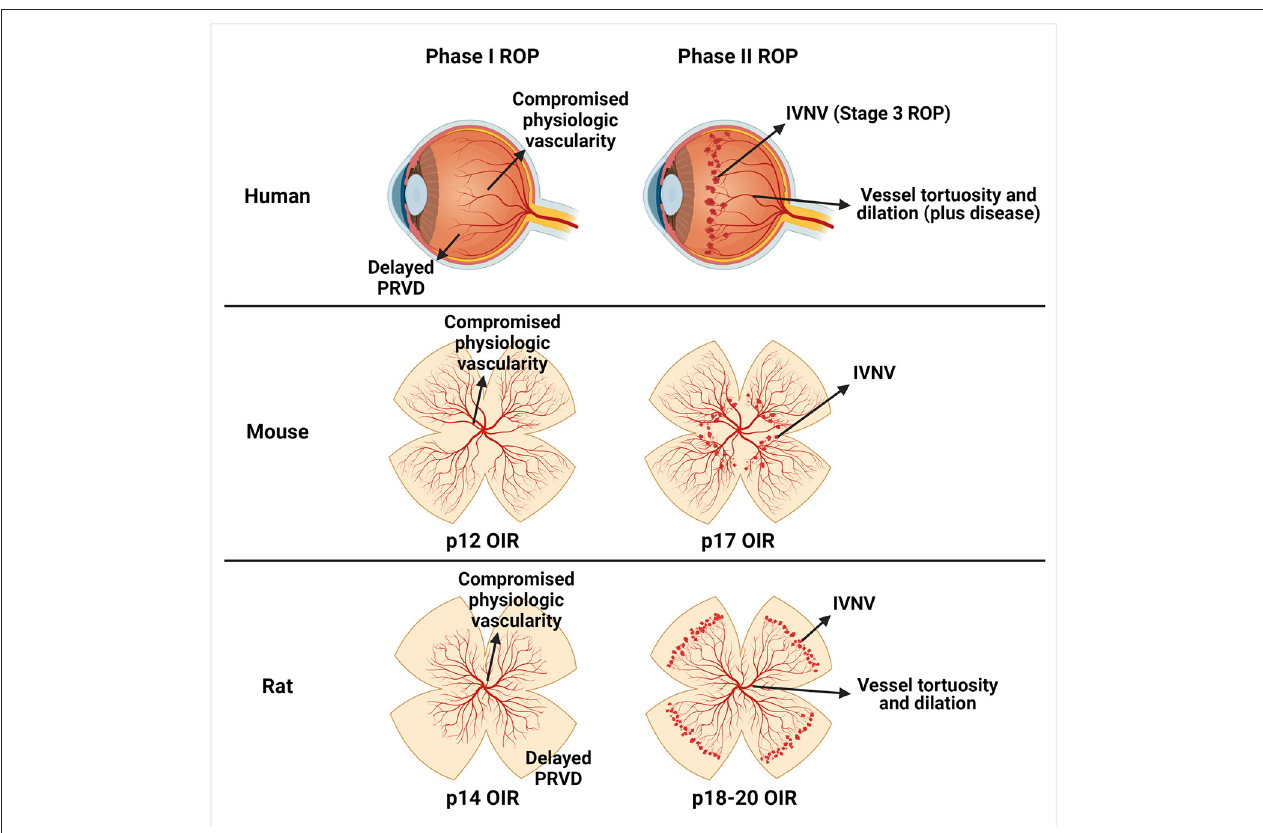
FIGURE 1 | Schematic representation of similarities between human retinopathy of prematurity (ROP) and oxygen-induced retinopathy (OIR) models. Human ROP is described by a two-phase hypothesis (row 1). In Phase I, events surrounding preterm birth (i.e., lack of maternally derived factors, relative hyperoxia, repeated